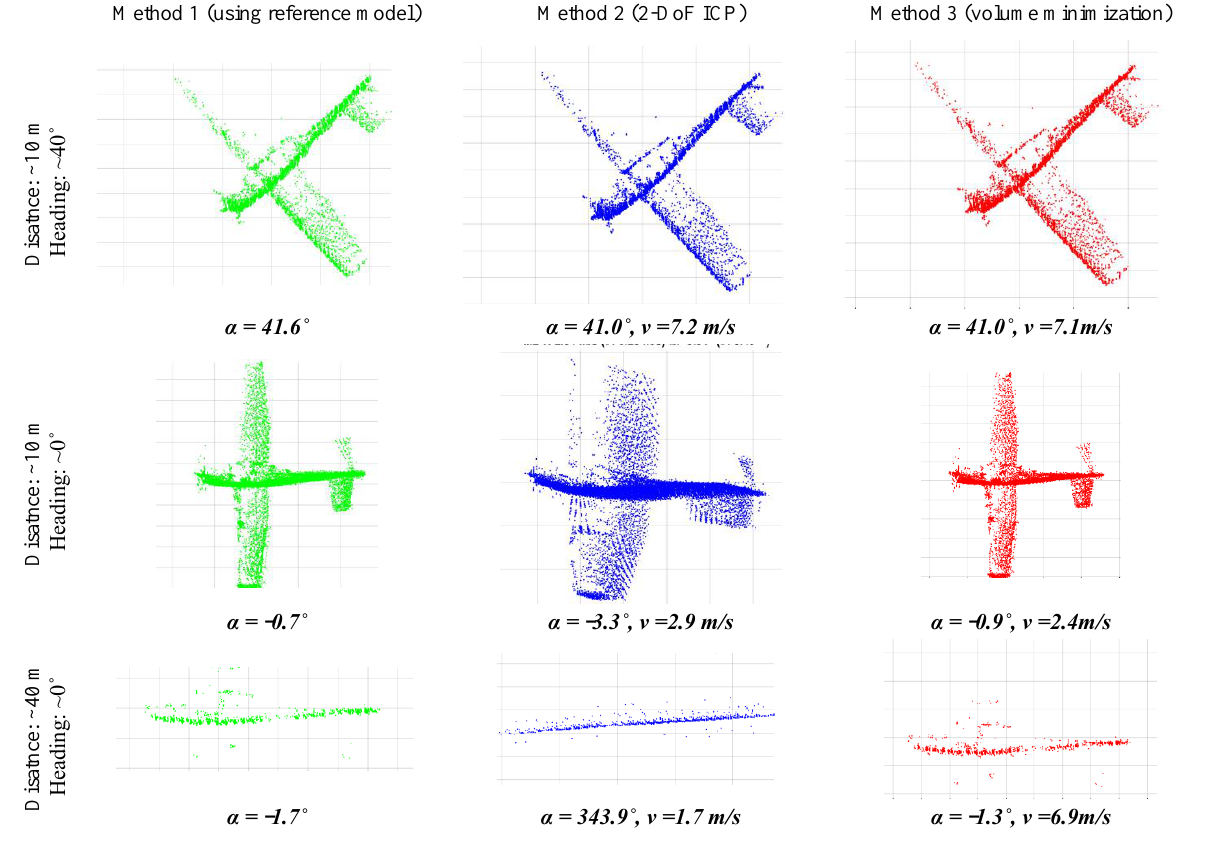
Figure 11. Comparison of the different solutions, top view